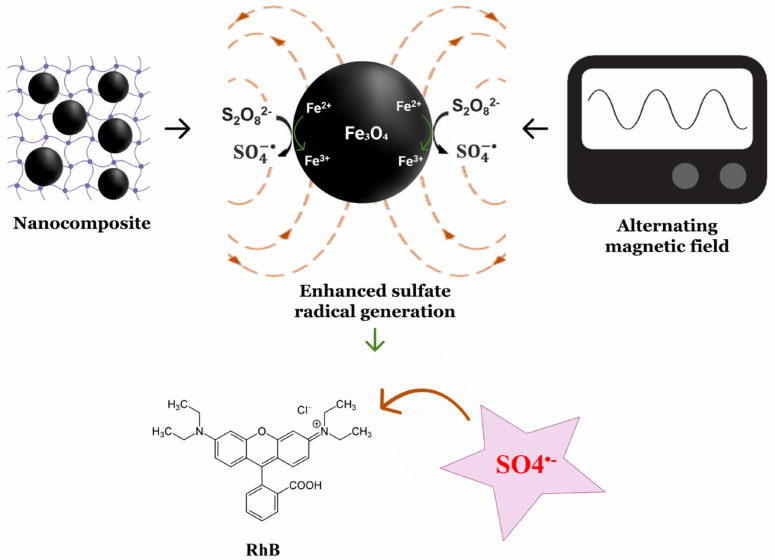
Figure 5. Potential mechanism for the production of enhanced sulfate radicals for RhB degradation. Created using